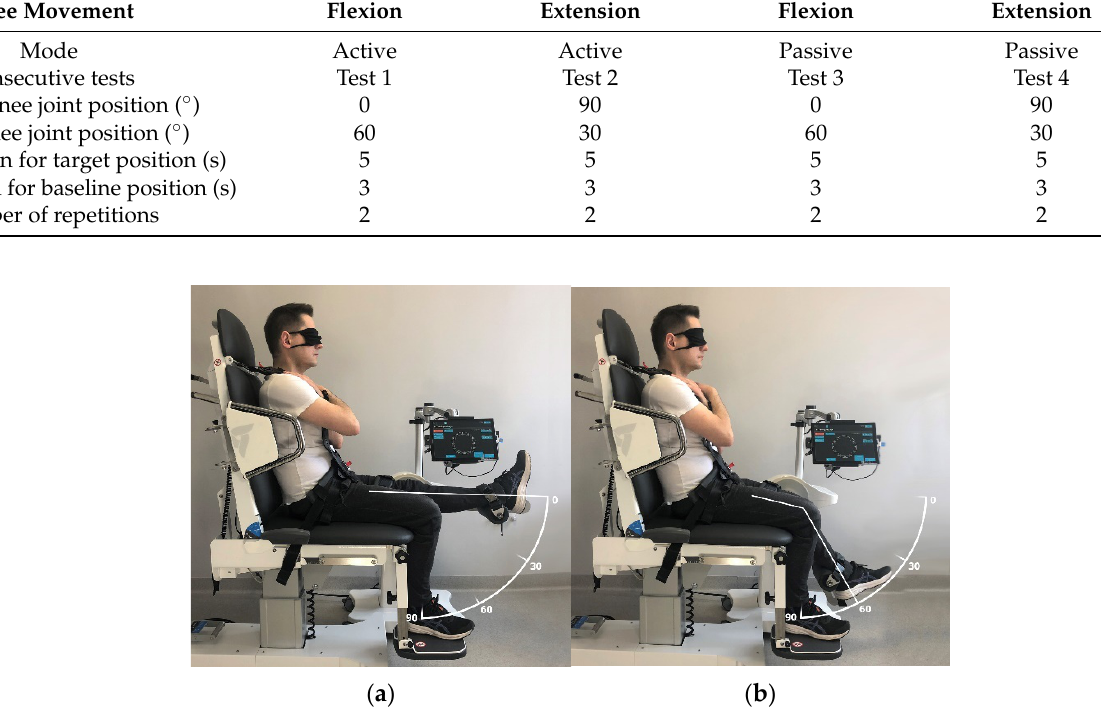
Table 1. Description of joint position sense (JPS) assessment procedure.